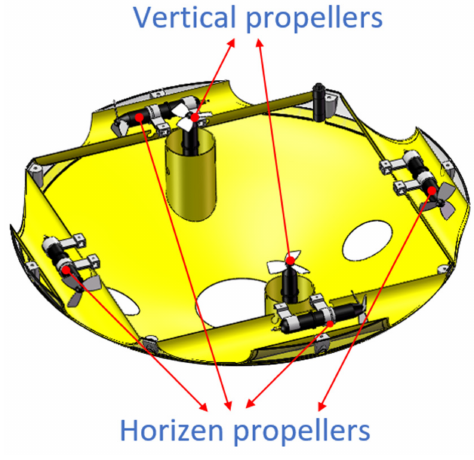
Figure 3. Propellers layout.